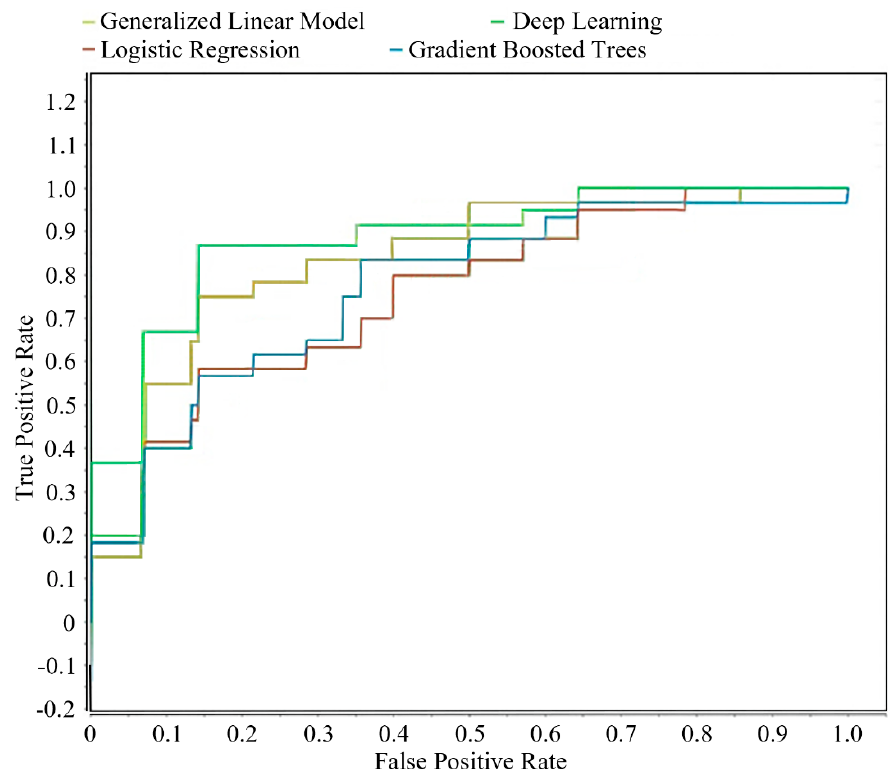
Figure 3. ROC of the proposed machine-learning models.